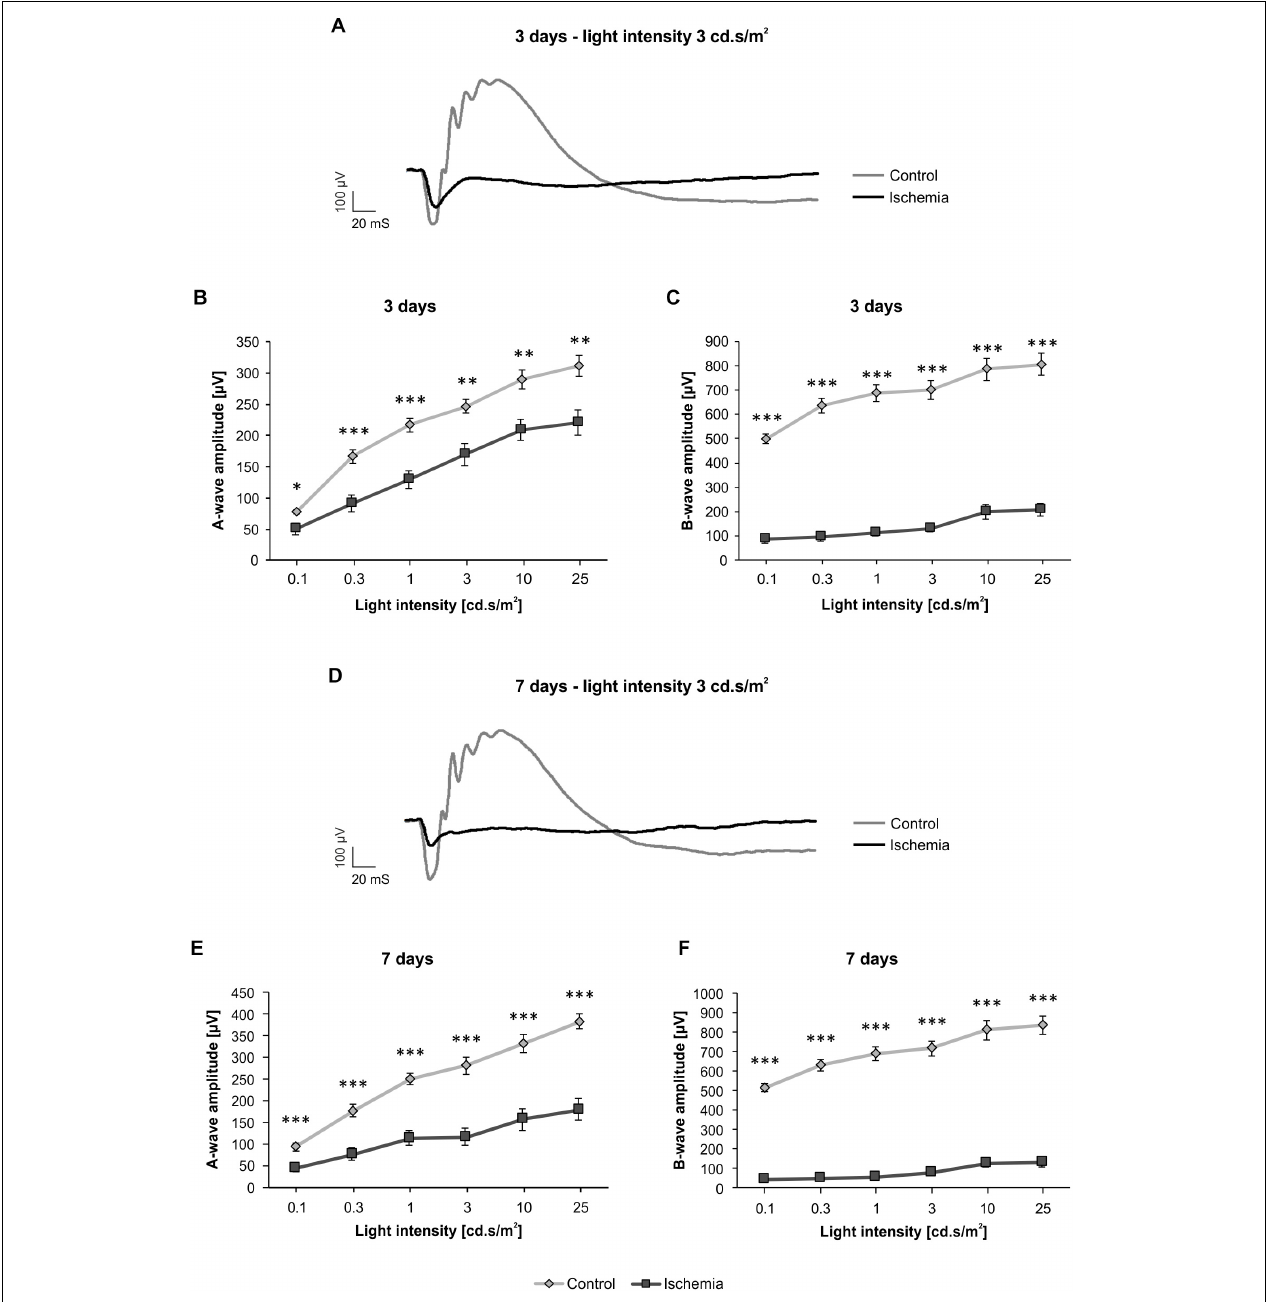
FIGURE 1 | Electroretinogram (ERG) measurements were performed 3 ( n = 9/group) and 7 ( n = 10/group) days after ischemia induction. (A) Representative ERG recording 3 days after ischemia induction. The average graph of the obtained waveforms of control eyes and the contralateral ischemic eyes at 3 cd.s/m 2 is shown. (B) A significant decrease of the a-wave amplitude ( p < 0.05) was noted in ischemic eyes compared to control ones 3 days after I/R at all measured light intensities. (C) Additionally, a significantly lower b-wave amplitude ( p < 0.001) was revealed in the ischemic group at this point in time. (D) Representative ERG recording 7 days after I/R. The average graph of the obtained waveforms of control eyes and the contralateral ischemic eyes at 3 cd.s/m 2 is represented. (E) 7 days after ischemia induction, the significant reduction of the a-wave amplitude ( p < 0.001) was still prominent and more pronounced. (F) A similar effect could be observed regarding the b-wave amplitude ( p < 0.001) at this point in time. ∗ p < 0.05, ∗∗ p < 0.01, ∗∗∗ p < 0.001.